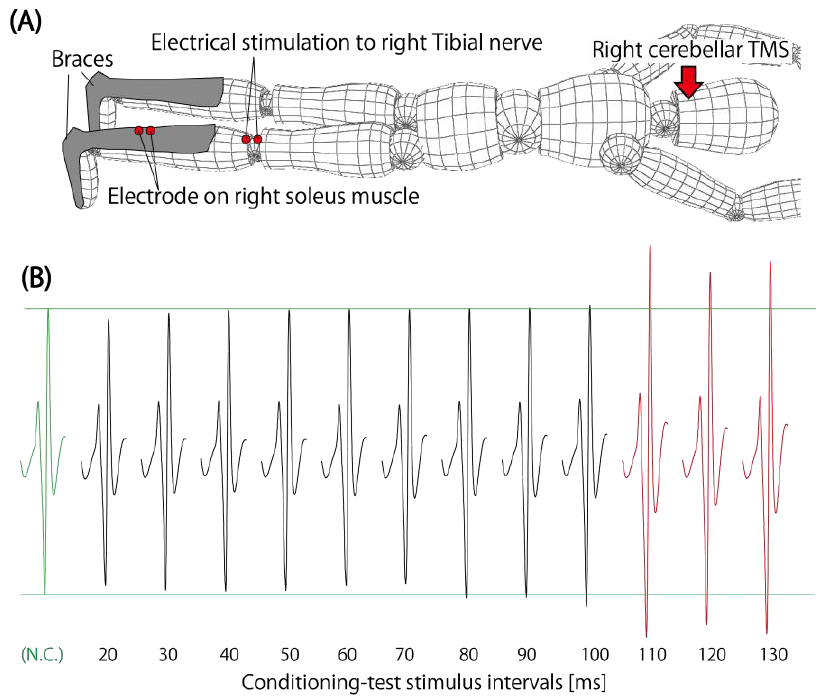
Figure 4. Typical setting used to test CSpF ( A ) and typical waveform of H-reflex conditioned by cerebellar TMS ( B ). In A , a single-pulse TMS is administered to the right cerebellar hemisphere prior to the application of electrical stimulation to the right tibial nerve in order to elicit the H-reflex on the right soleus muscle. The location of TMS is indicated by a red arrow, while red circles illustrate the location of the electrode used for electrical stimulation and EMG recording. In B , the H-reflex waveforms in each conditioning-test stimulus interval are described. The green waveform denotes the non-conditioned (N.C.) H-reflex, while the other waveforms represent the conditioned H-reflex, which are normalized by N.C. H-reflex amplitude. The green horizontal lines indicate the amplitude of the non-conditioned H-reflex (control condition), and the distance between green lines indicate 100% of N.C. H-reflex amplitude. The red waveforms at the 110 – 130 ms intervals signify the H-reflex, which is significantly facilitated by cerebellar TMS, as reported in a previous study [46]. It is worth noting that these settings and waveforms were initially generated based on the aforementioned study [46] for this review manuscript and were not previously published.